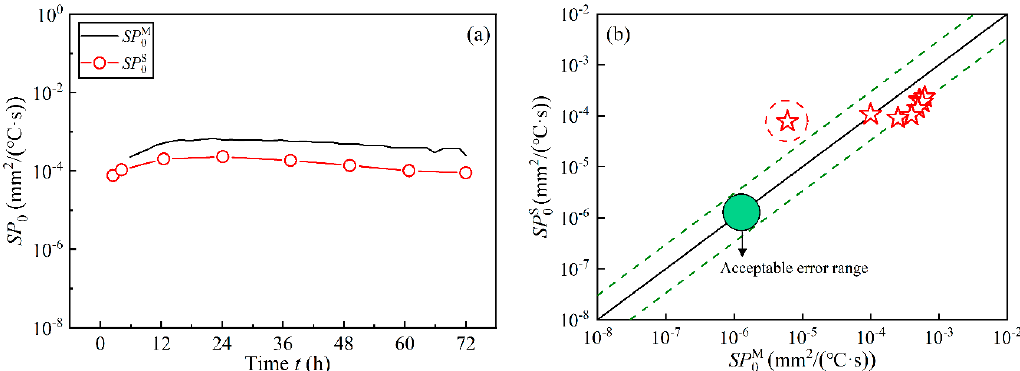
Figure 9. ( a ) Variation of the segregation potential SP 0 calculated by measured data and the simulated data.